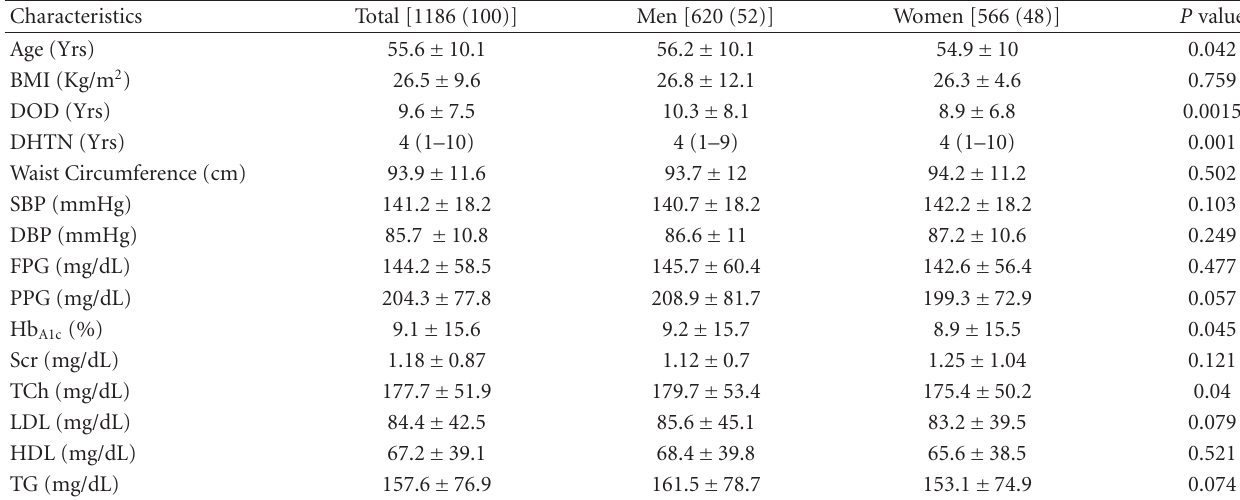
Table 1: Demographic and clinical parameters of hypertensive T2DM patients.